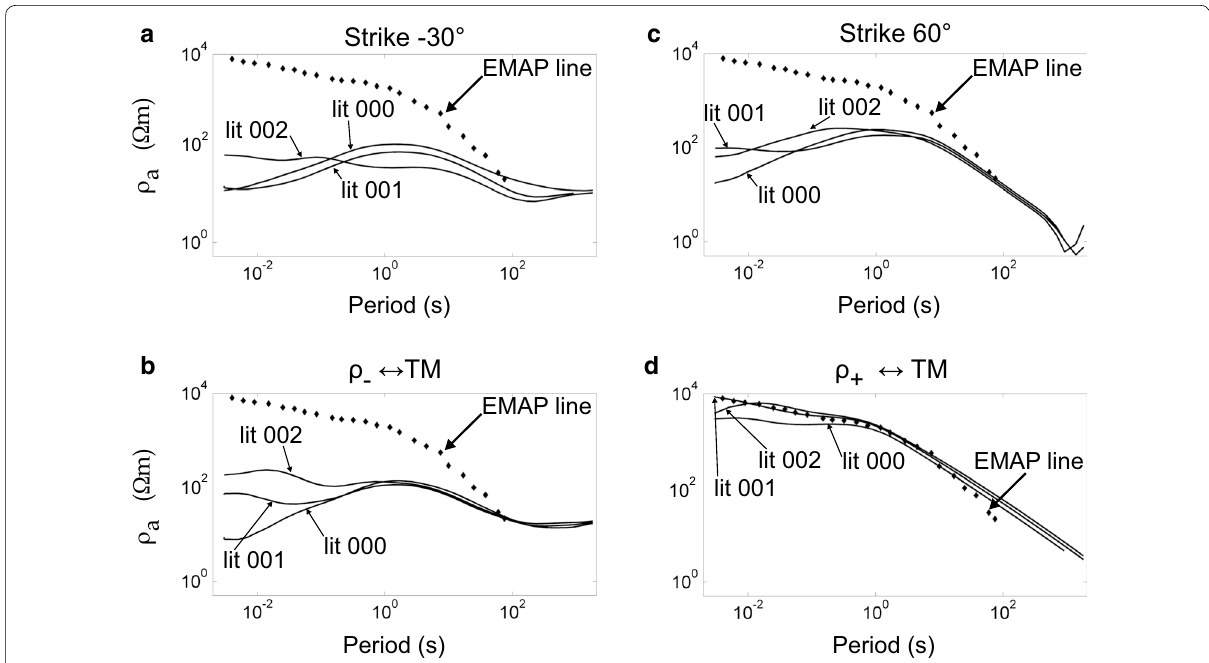
Fig. 12 The predicted static‑free TE apparent resistivity curves over the Nelson Batholith contrasted with the EMAP line of Jones et al. (1989). a N30°W and b its associated invariant ρ TM. c N60°E and d its associated invariant ρ − ↔ + ↔